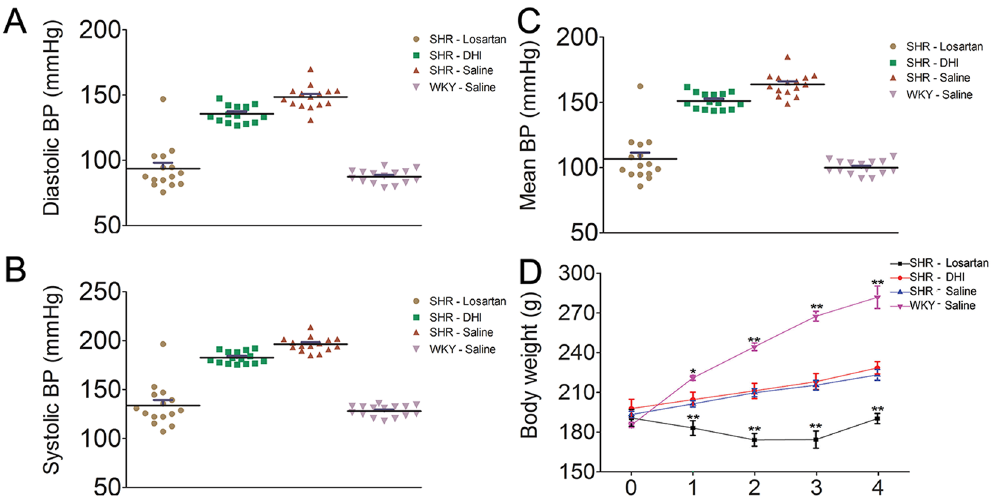
Figure 1. Effects of DHI on noninvasive blood pressure in SHR. Panel A–C are representative data plots from (DBP, SBP, and MBP measurements, respectively) using noninvasive tail-cuff method in conscious rats. Panel D represent body weight in (gram) measured with the small animal weighing scale. Compared with saline control, DHI-treated SHR showed no significant difference (p > 0.05 vs. saline group) in weight over the 4 weeks of routine treatment. Data are expressed as mean ± SEM, n = 4.